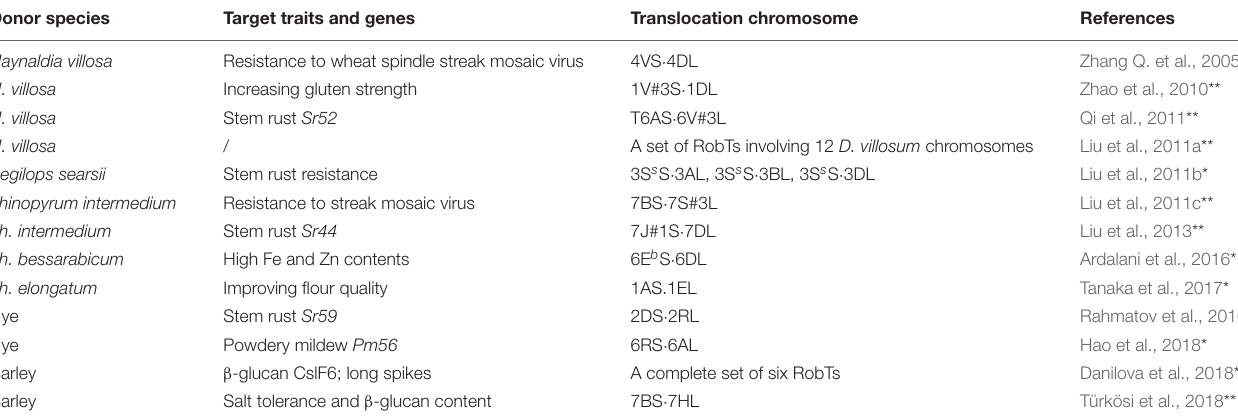
TABLE 1 | Examples of compensating Robertsonian translocations generated by double monosomic